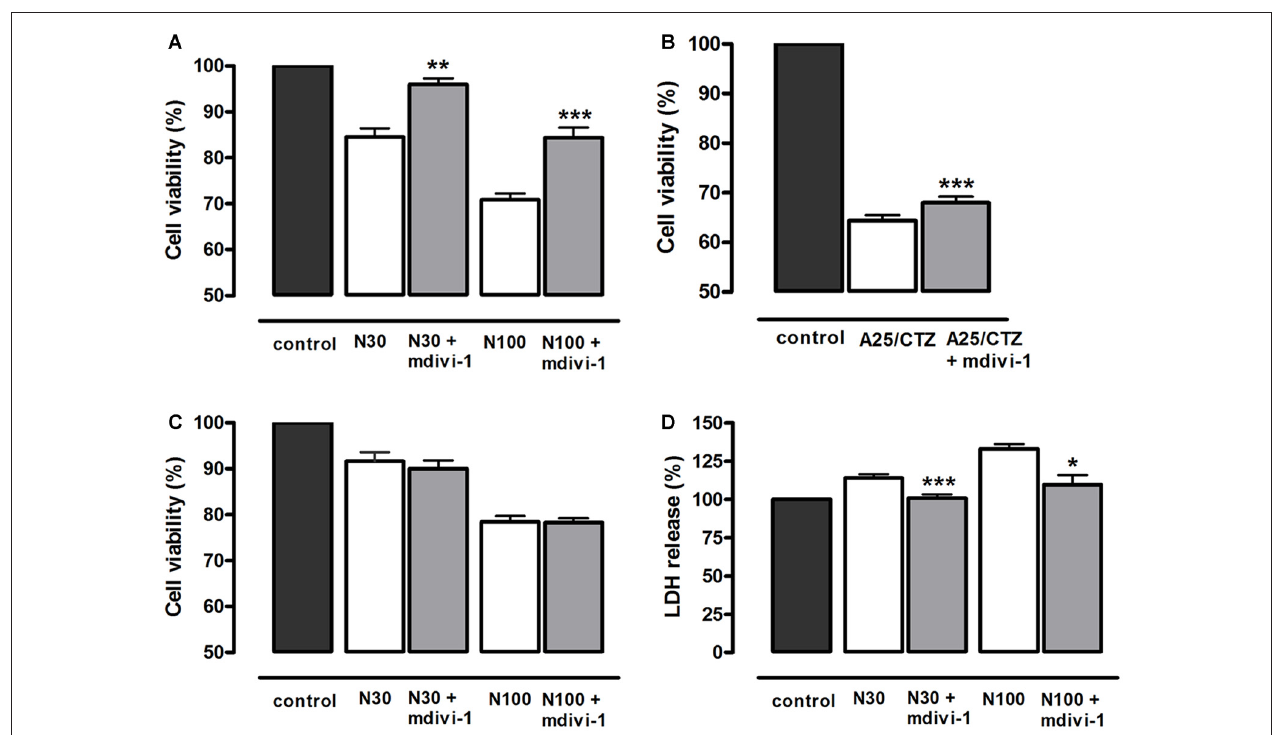
FIGURE 2 | Mdivi-1 protects neurons from excitotoxicity. (A,B) Neurons were stimulated with (A) NMDA (30 µ M and 100 µ M, 30 min) or (B) AMPA (25 µ M, 30 min) and (CTZ, 100 µ M) in the presence or absence of mdivi-1 (50 µ M, 1 h) and 24 h later cell viability was assessed by the quantification of vital dye calcein-AM fluorescence ( n = 6 and n = 8, respectively). (C) Neurons were exposed to mdivi-1 (50 µ M) after being stimulated with 30 and 100 µ M of NMDA for 30 min, and 24 h later cell viability was assessed by the analysis of calcein-acetoxymethyl (AM) fluorescence ( n = 3). (D) Neurons were stimulated with 30 µ M and 100 µ M of NMDA for 30 min in the presence or absence of mdivi-1 (50 µ M, 1 h) and 1 h later LDH release to the extracellular medium was quantified ( n = 4). Data represent means ± SEM of normalized calcein fluorescence values. ∗ p < 0.05, ∗∗ p < 0.01, ∗∗∗ p < 0.001 compared with control (NMDA or AMPA/CTZ alone), paired Student’s t